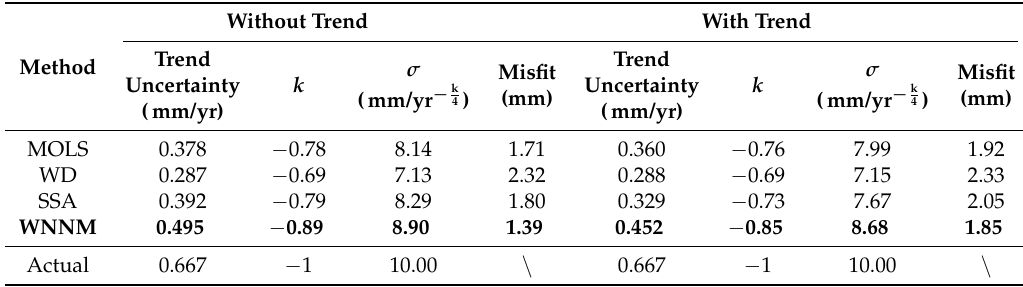
Table 2. Mean results of trend uncertainty, spectral index, noise amplitude and misfit estimated from 500 simulations under different strategies, where σ f = 10mm/yr − k 4 .